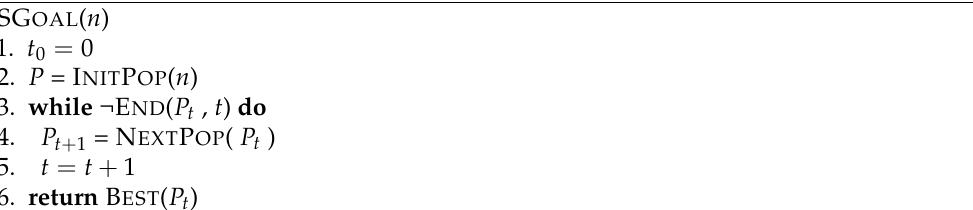
Algorithm 1 Stochastic Global Optimization